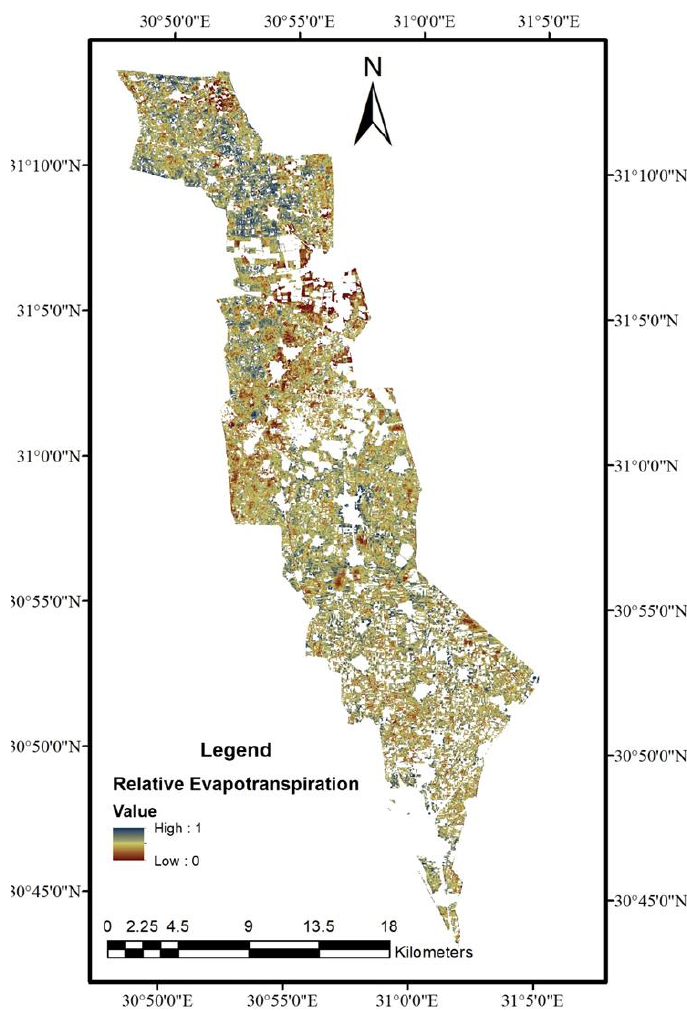
Figure 9. Distribution of the relative evapotranspiration of the study area during the winter season (from November 2015 to May 2016). (from November 2015 to May